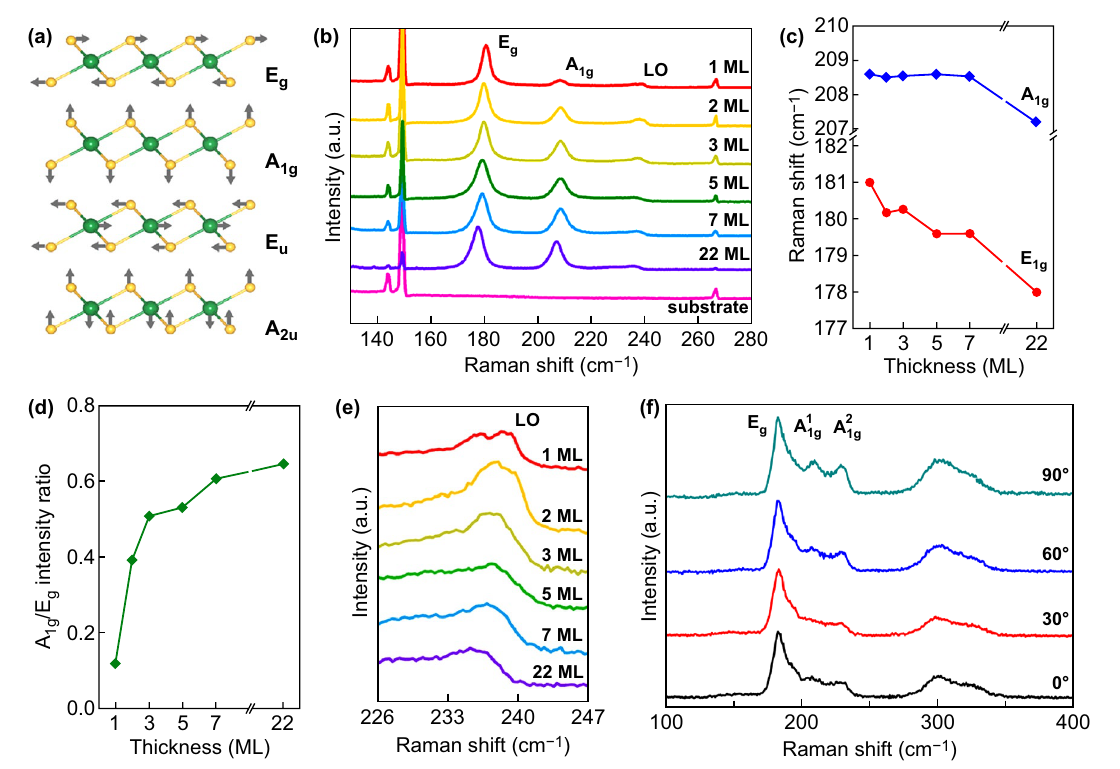
Fig. 5 Vibrational properties of PtSe 2 . a Schematic views of Raman vibrational modes in PtSe 2 . b Thickness‑dependent Raman spectra of PtSe 2 . c The E g and A 1g peak positions of PtSe 2 with increase in thickness. d Analysis of thickness dependent of A 1g /E g intensity ratio. a–d Reproduced with permission [43]. Copyright 2017, IOP Publishing. e Zoom in Raman spectra of the LO mode. f Polarization‑dependent Raman spectra of PtSe 2 . Reproduced with permission [28]. Copyright 2018, John Wiley and